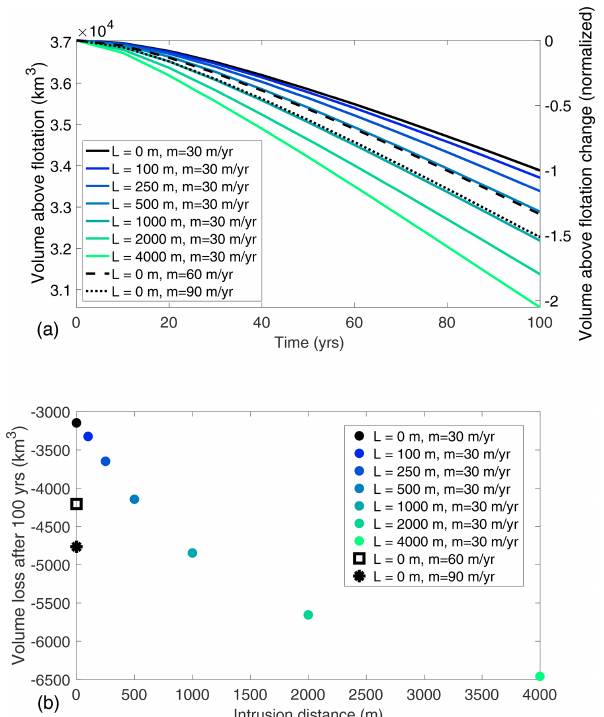
Figure 6. ISSM simulations of transient ice volume loss in the MIS- MIP+ configuration over 100 years with varying distances of “high” ( ˙ m GL = 30myr − 1 ) intrusion-induced basal melt upstream of the grounding line and increased submarine melt rates with no intru- sion for comparison. (a) Transient ice volume loss over 100 years. Color variation shows different prescribed intrusion distances, and dashed and dotted lines show higher submarine melt rates with no intrusion. (b) Total ice volume loss at the end of 100 years as a function of intrusion distance.